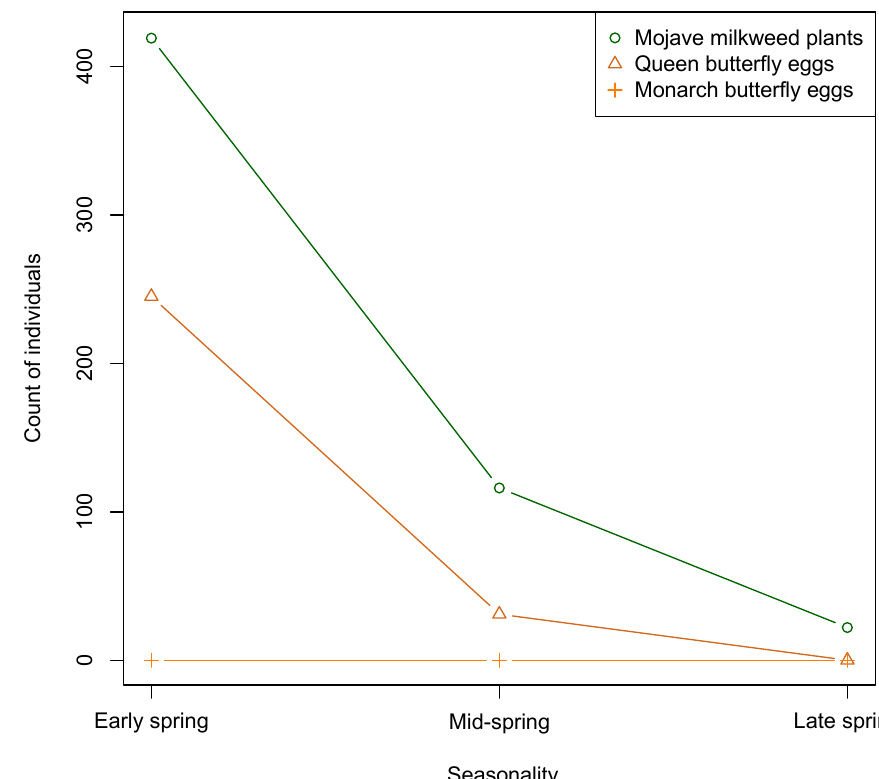
Figure 3. Count of monarch and queen butterfly eggs and Mojave milkweed plants recorded